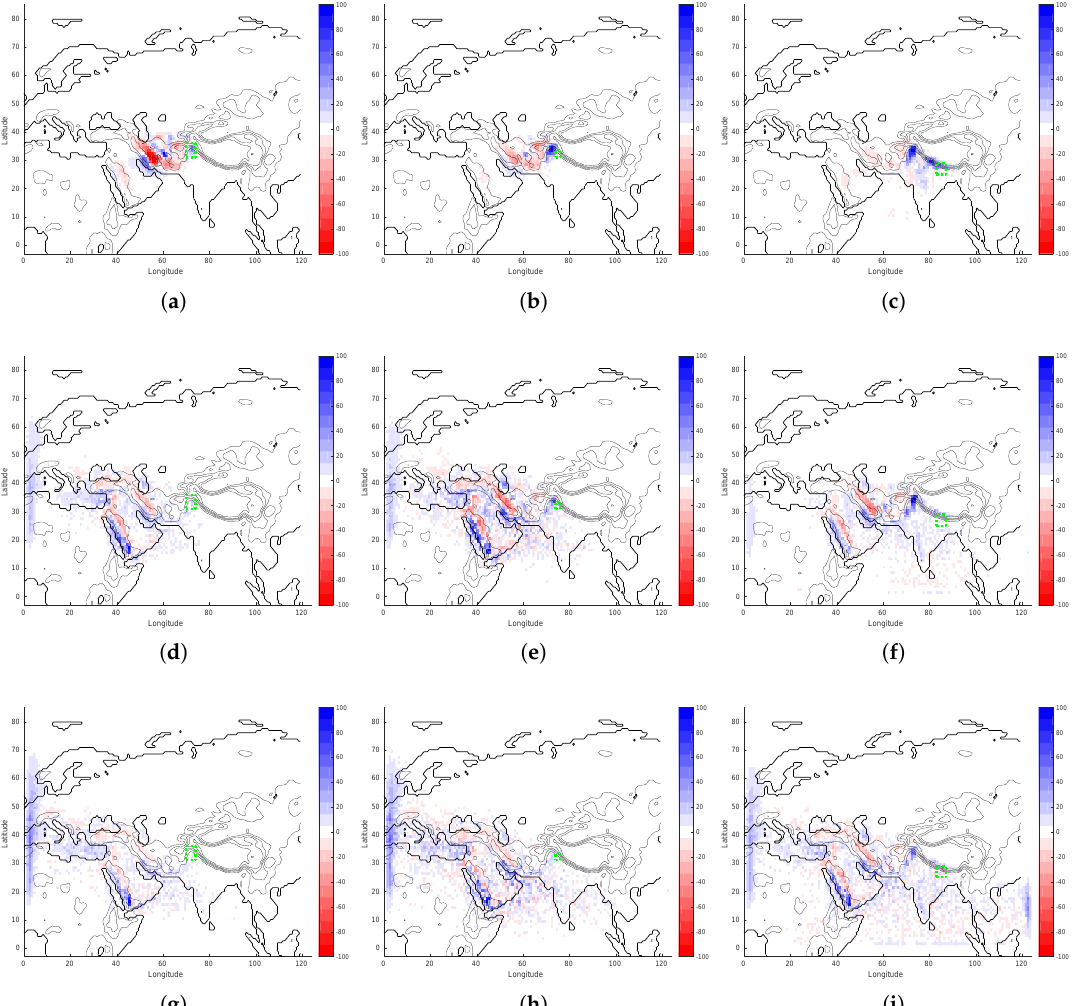
Figure 7. Winter (NDJ) column integrated climatology (1980–2016), of the moisture sources and sinks, for all parcels over each 1 ◦ area, originating from: ( a ) NP , 2 days back in time, along the parcel trajectory; ( b ) U , 2 days back in time, along the parcel trajectory; ( c ) K , 2 days back in time, along the parcel trajectory; ( d ) NP , 6 days back in time, along the parcel trajectory; ( e ) U , 6 days back in time, along the parcel trajectory; ( f ) K , 6 days back in time, along the parcel trajectory; ( g ) NP , 10 days back in time, along the parcel trajectory; ( h ) U , 10 days back in time, along the parcel trajectory; ( i ) K , 10 days back in time, along the parcel trajectory. The area of interest is illustrated by a green dashed box. The colour bar scale shows the relative difference of the change in specific